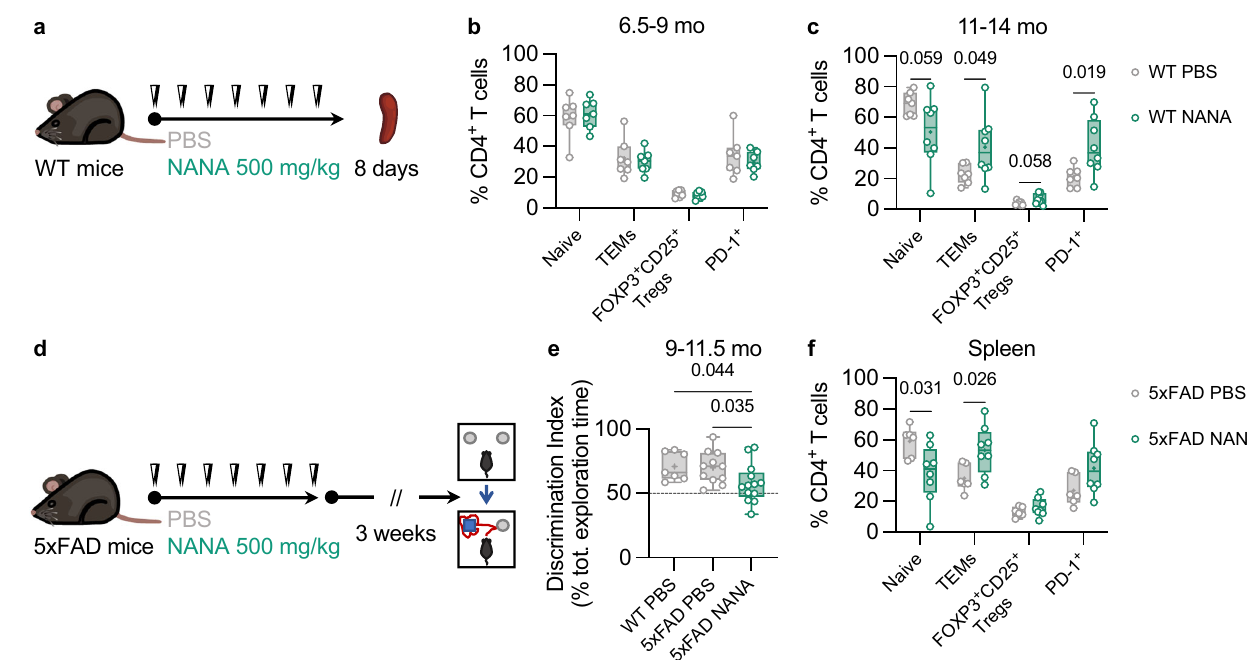
Fig. 7 | NANA administration induced CD4 + T-cell deregulation in vivo and accelerated cognitive decline in 5xFAD mice. a – c Effect of NANA administration on the spleen immune pro fi le of WT mice. a Schematic presentation of treatment regimen.NANAorPBScontrolwassubcutaneouslyinjectedtwiceaday,onceinthe morning (white arrowheads) and once in the evening (black arrowheads), for 7 consecutive days. b , c Flow cytometric quanti fi cation of splenic frequencies of CD4 + naive T cells (CD44 low CD62L high ), CD4 + TEMs (CD44 high CD62L low ), CD4 + FOXP3 + CD25 + Tregs,andCD4 + PD1 + Tcellsinyoung-adult( b )andmiddle-aged mice ( c ). For both ( b ) and ( c ), data from two independent experiments, sample n : b ,PBS=7,NANA=7; c ,PBS=7,NANA=8.Statisticalanalyses: b ,multipletwo-tailed unpaired Student ’ s t tests; c , multiple two-tailed unpaired Student ’ s t tests with Welch ’ s correction (Methods, Statistical analyses section). d – f Effect of NANA on novelty discrimination and CD4 + T-cell pro fi le in 5xFAD female mice. d Schematic